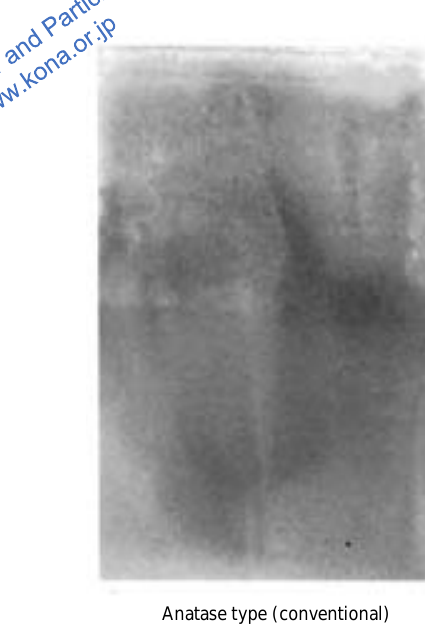
Fig. 7 Dye decomposing ability of visible light-responsive photocatalyst coating layer (after 12 hours of irradiation onto the upper half with a white fluorescent